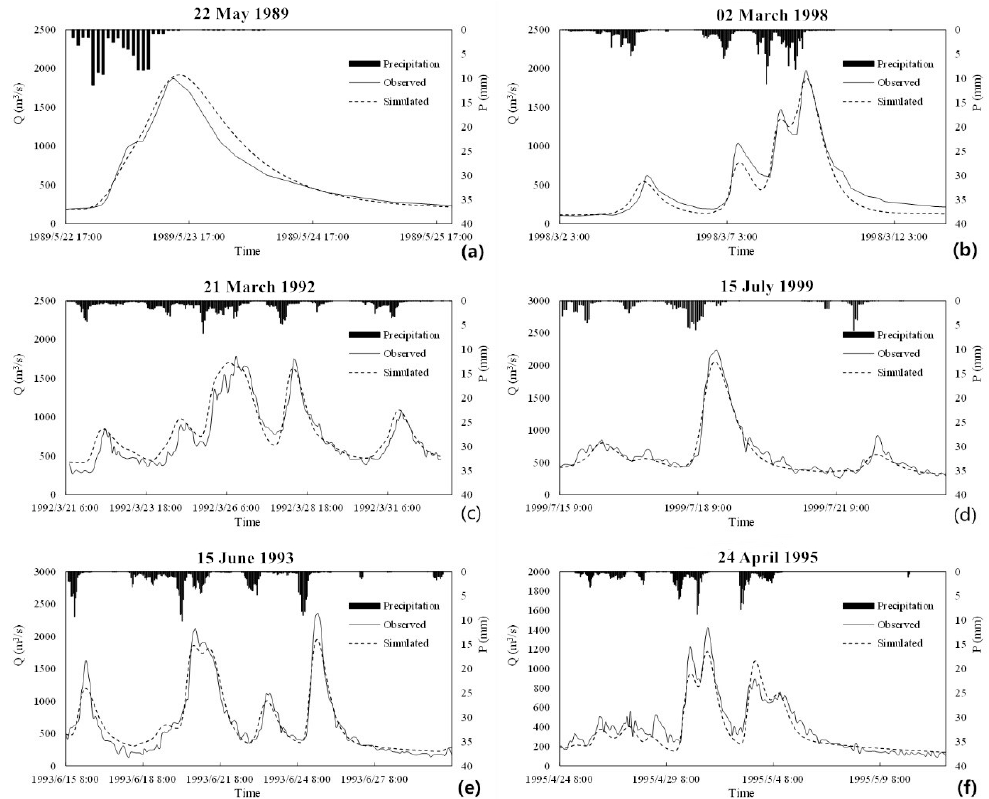
Figure 5. The discharge simulating graphs of two flood events in each watershed: ( a ), ( b ) belong to Shaowu basin; ( c ), ( d ) are for Jianyang basin; ( e ), ( f ) are for Shuiji catchment; the left graphs ( a ), ( c ), ( e ) belong to the calibration stage and the right ( b ), ( d ), ( f ) are in validation step.